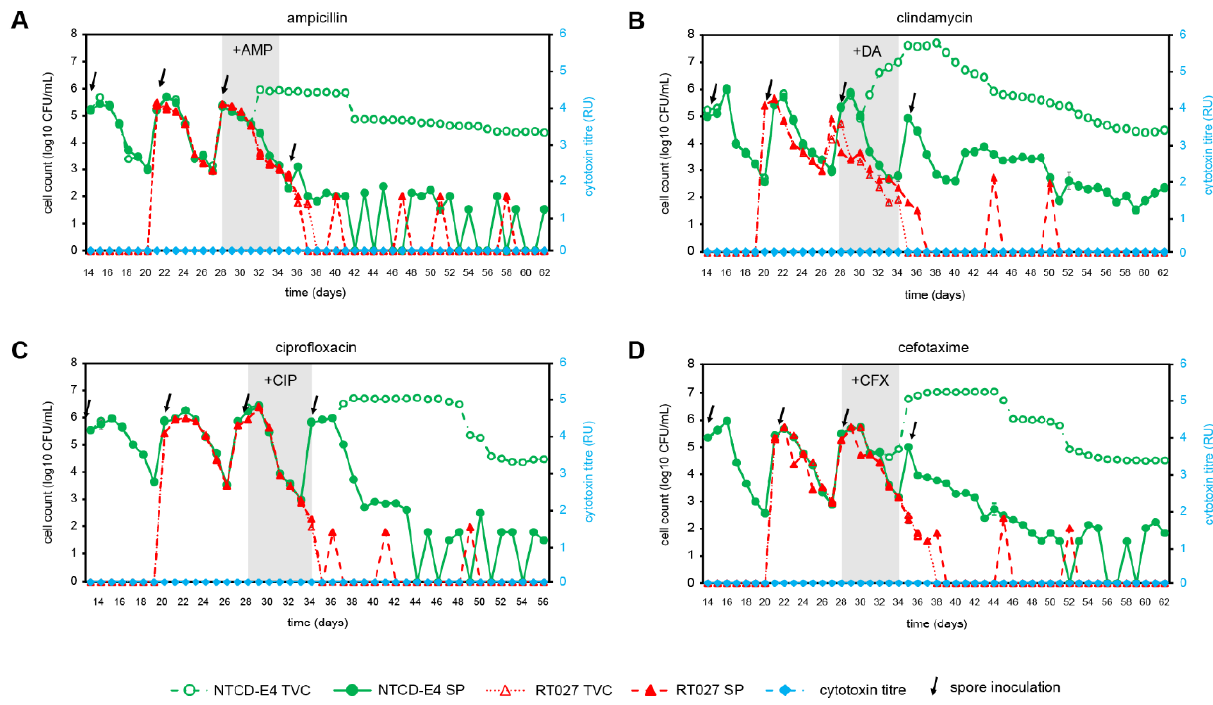
Figure 2. Effect of antimicrobial agents (ampicillin, AMP; clindamycin, DA; ciprofloxacin, CIP; cefotaxime, CFX) on C. difficile strains, NTCD-E4 and RT027 in a competition gut model of NTCD-E4 and RT027, total viable counts (TVC), spore counts (SP), and cytotoxin titres (RU) in a human gut model (Vessel 3, pH 6.8). Brazier’s agar was used to culture all C. difficile strains, incorporating tetracycline (TET, 0.5 mg/L) for RT027 and clindamycin (DA, 10 mg/L) for NTCD-E4. Spore counts were determined following an alcohol shock, and cytotoxin titers (relative units, RU) were determined using a Vero cell cytotoxicity assay. ( A ), AMP, 8 mg/L, 8-hourly; ( B ), DA, 33.9 mg/L, 6-hourly; ( C ). CIP, 139 mg/L, 12-hourly; ( D ), CFX, 20 mg/L, 12-hourly. Table 2. Changes (log 10 cfu/mL) in viable counts of gut microbiota groups following exposure to antimicrobial agents in a human gut